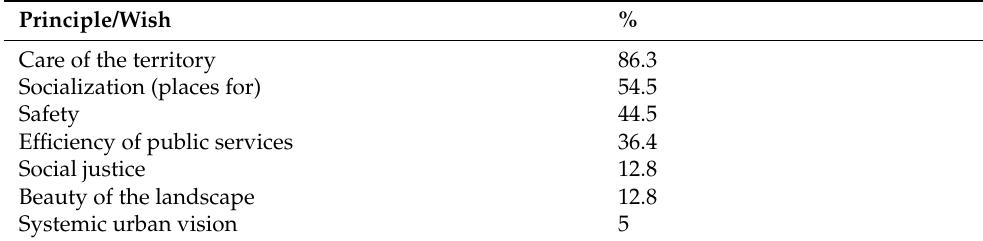
Table 2. List of principle/wihes of the community of